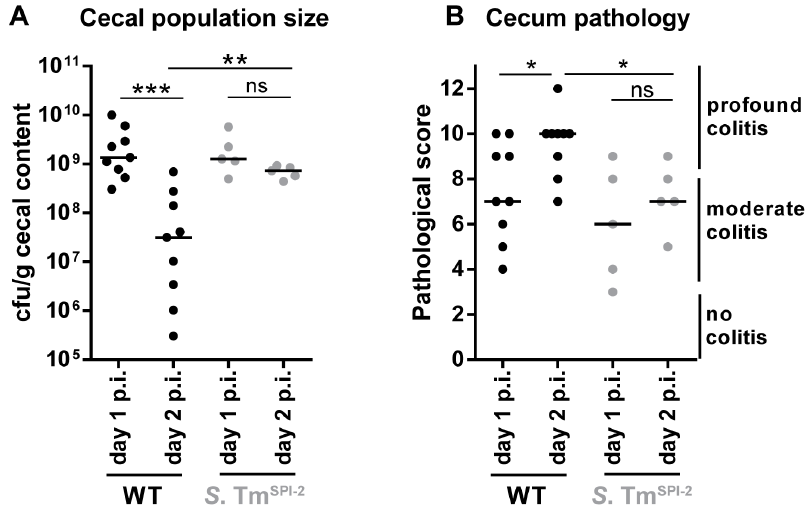
Fig. 5. Decrease in cecal population size between day 1 and day 2 p.i. only occurs during S. Tm WT induced inflammation, but not during inflammation in a SPI-2 deficient background. Streptomycin-pretreated C57BL/6 mice were orally infected with S. Tm WT or S. Tm SPI-2 , respectively. Mice were sacrificed at day 1 or day 2 p.i. and bacterial population size (A) and cecum pathology at the day of sacrifice (B) were plotted. ns=not significant (P $ 0.05), * P , 0.05, ** P , 0.01, *** P , 0.001; Mann-Whitney U